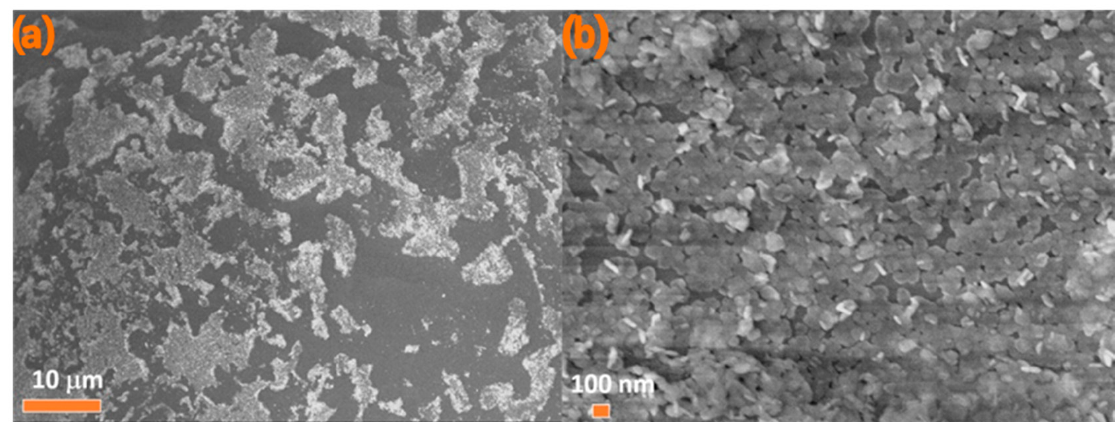
Figure 5. SEM image of Sample 7.